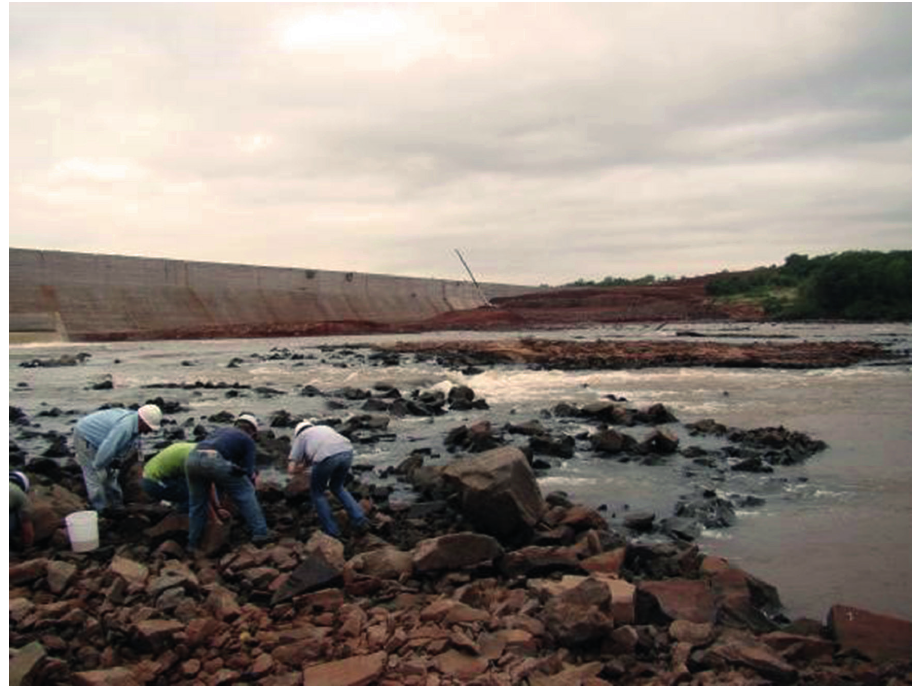
FIGURE 4 | Type-locality of Pareiorhaphis pumila , rio Ijuí below dam of Passo de São José hydropower